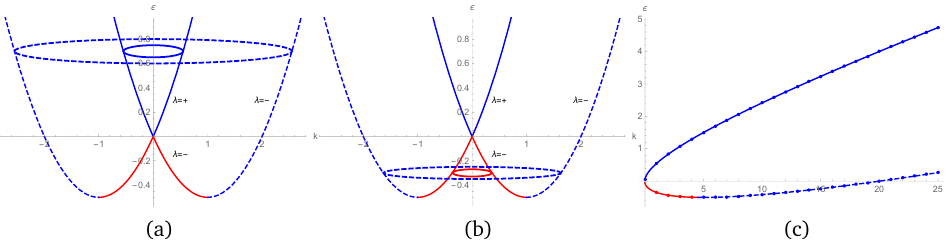
2 + λ k [ ε is in units of m ] as 2 m ) , k x y [ in units of ¯ n , λ − λ between 0 and 25 for λ = + (blue) and 2 π B = 0.1 and we considered the case ˜ g = m 2